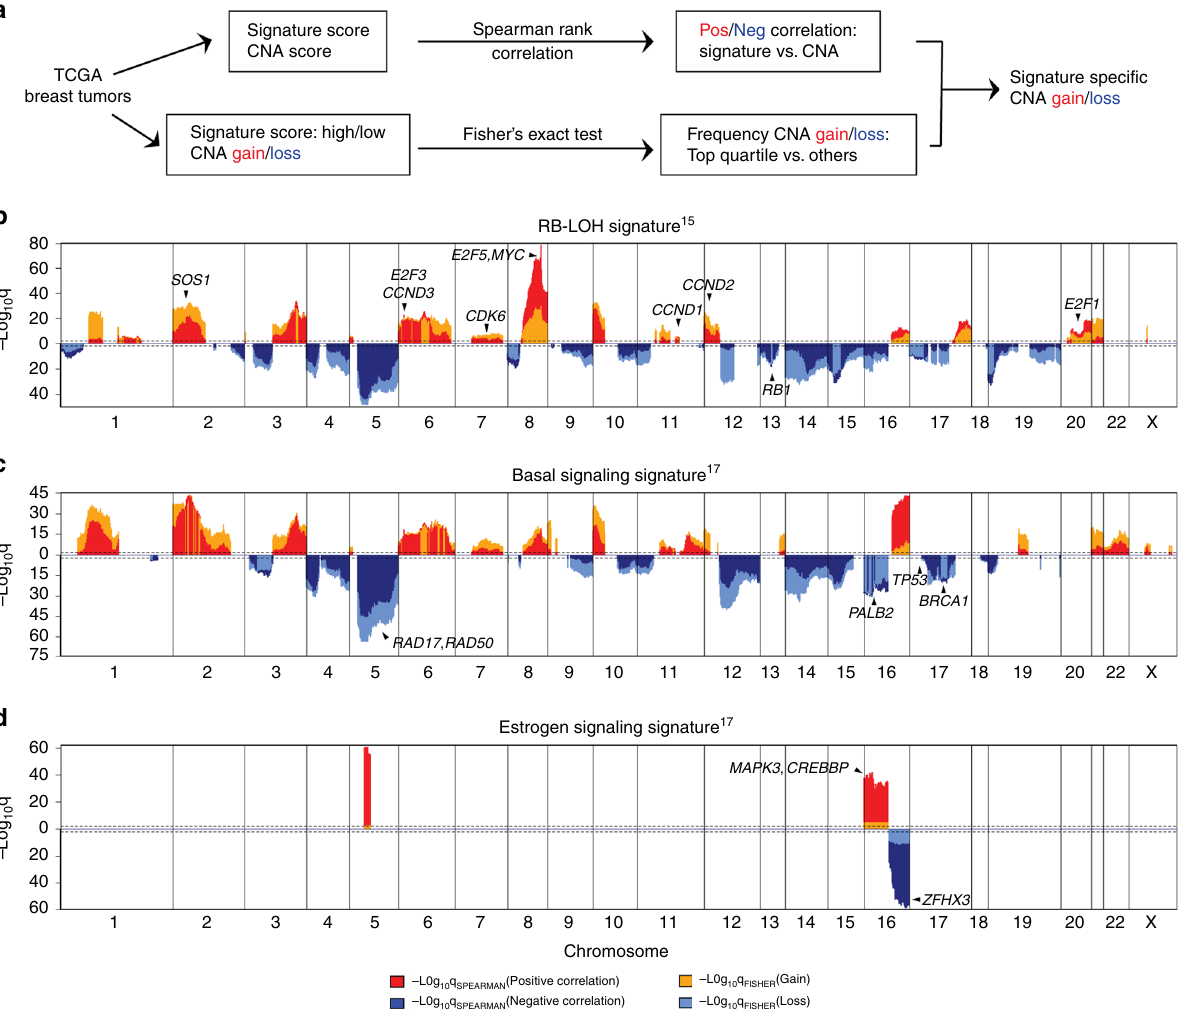
Fig. 1 Identi fi cation of gene expression signature-speci fi c copy number alterations in breast cancer. a Schematic overview of the strategy used to identify CNAs associated with gene signatures. Gain/loss indicates DNA copy number gains or losses; Pos/Neg indicates positive or negative association. b – d Spearman rank correlation was used to identify genes positively (red) or negatively (dark blue) associated with gene signatures, and Fisher ’ s exact test was used to compare the frequency of copy number gains (orange) or losses (light blue) for RB-LOH ( b ), Basal signaling ( c ), and Estrogen signaling ( d ) Gene Program signatures. Dashed lines indicate the signi fi cance threshold ( q = 0.01). Only q -values for genes signi fi cant in both analyses were plotted. Black arrowheads indicate known pathway drivers. In each fi gure, chromosomal boundaries are indicated by vertical black